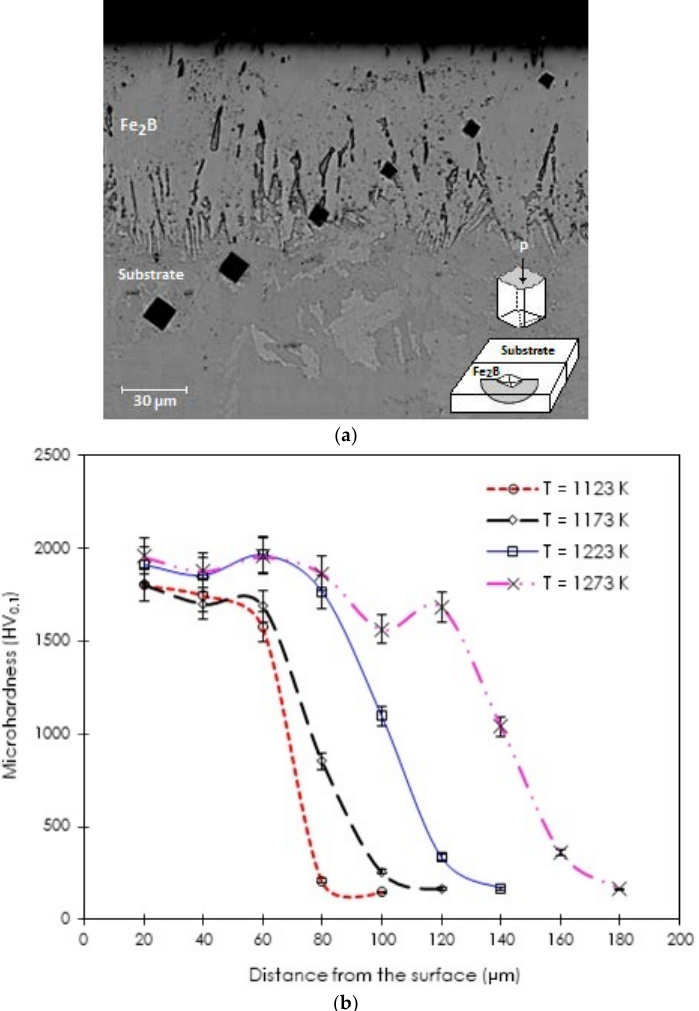
Figure 8. ( a ) Vickers hardness profile along the hardened layer by boriding for a borided sample of ASTM A283 steel for 4 h at 1173 K. ( b ) Describes the evolution of Vickers hardness depending on the displacement from the material surface towards its core for 8 h at 1123, 1173, 1223, and 1273 K (P = 98.1 × 10 –2 N).